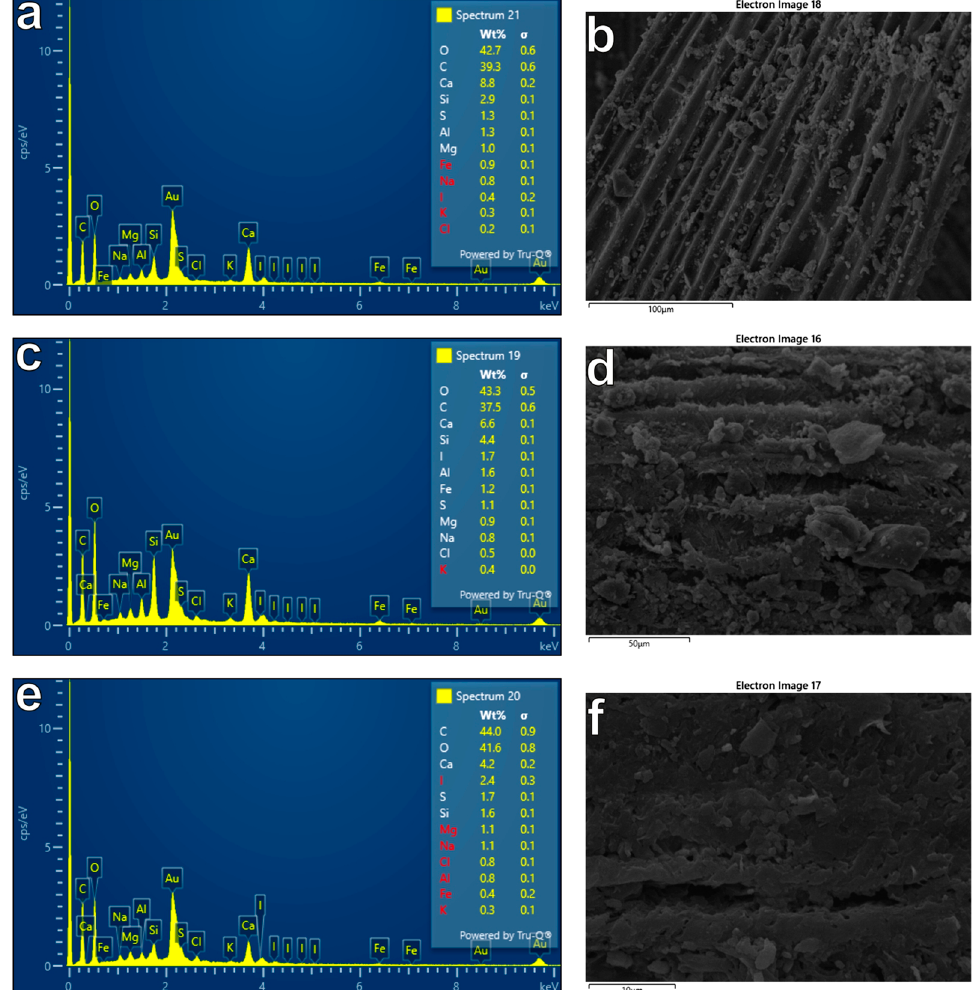
Figure 8. ( a – f ) Elemental analyses and back-scattered images (BSEI) of the investigated Posidonia oceanica balls. Table 2. Elemental analyses of Posidonia oceanica